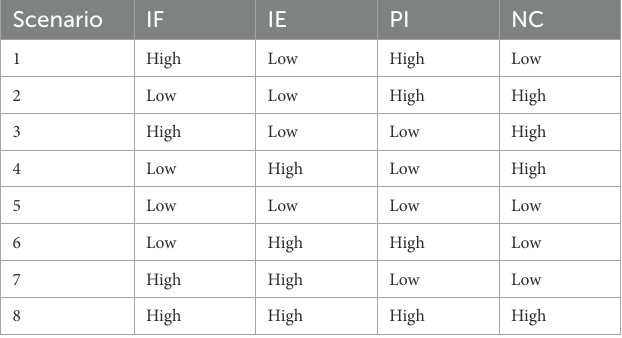
TABLE 4 Design of scenario